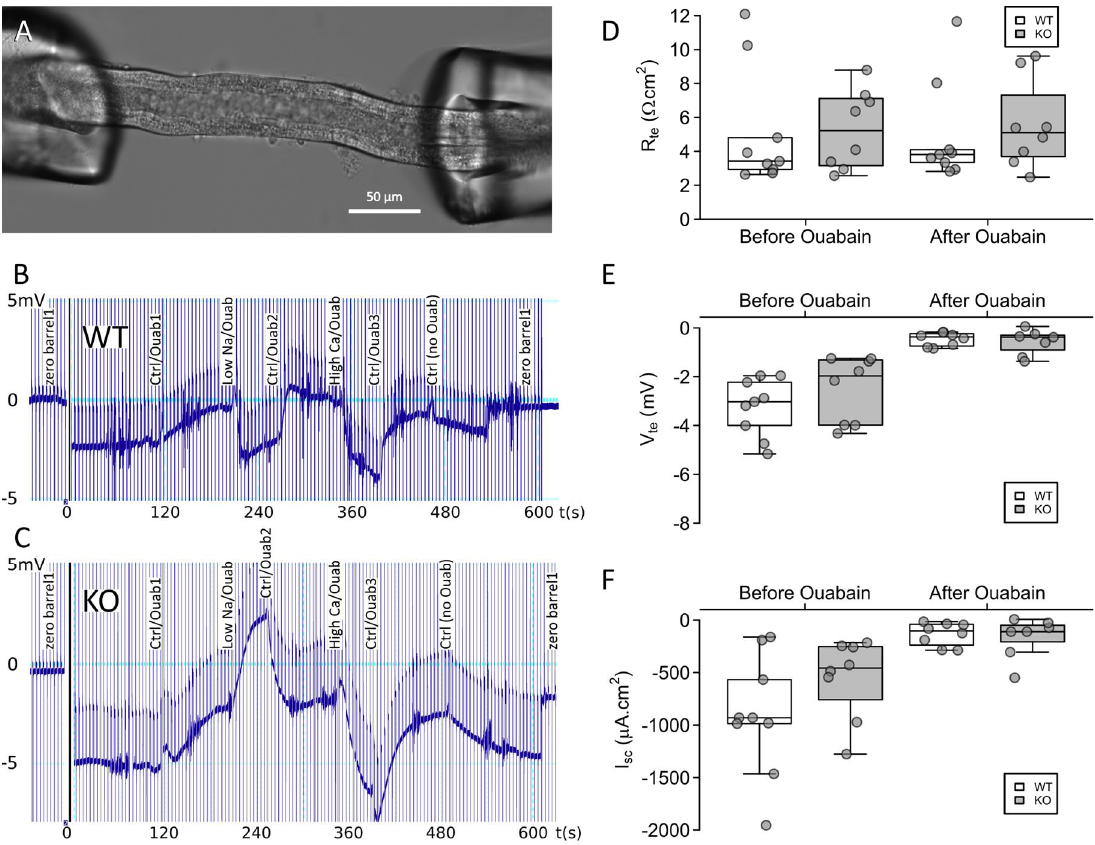
Figure 4. Microperfused proximal tubules from claudin-12 knockout (KO) and wild type (WT) mice. ( A ) Representative image of a proximal tubule perfused ex vivo. ( B , C ) Representative recording traces from original experiments in proximal tubules from WT ( B ) and KO ( C ) animals. Basolateral addition of ouabain, and solutions containing a low sodium or high calcium concentration altered the trace by first reducing transcellular transport, and then generating di ff usion potentials. ( D – F ) Transepithelial resistance (R te ), transepithelial voltage (V te ), and short-circuit current (I sc ) before and after the addition of ouabain.